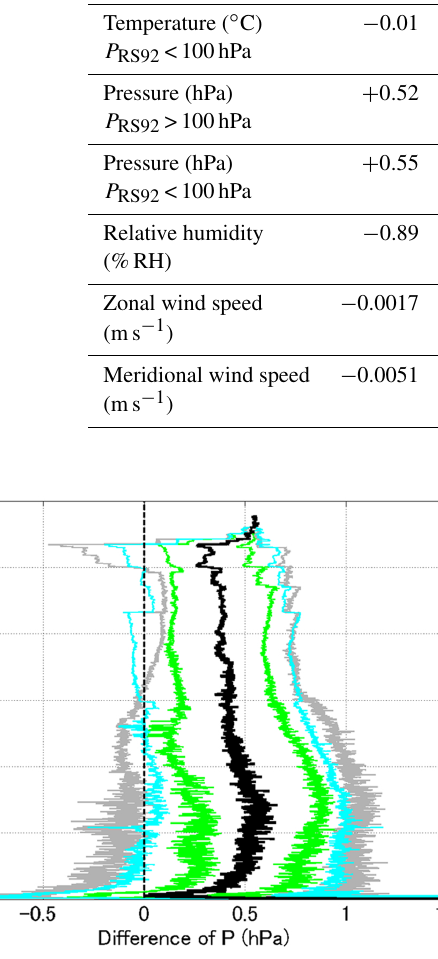
Figure 4. As in Fig. 3a but for between the RS41 GPS-derived and RS92 pressures